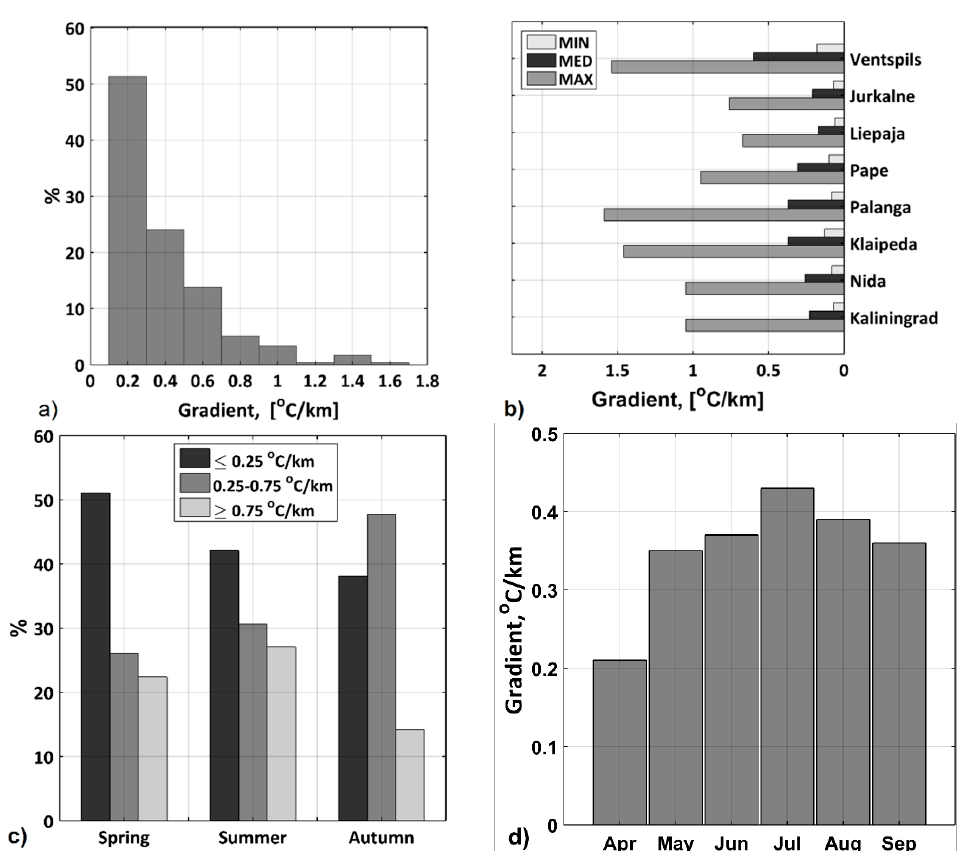
Figure 8. Upwelling-induced SST gradients for the period 2000–2015: ( a ) histogram of horizontal SST gradients; ( b ) spatial distribution of SST gradients along the SEB coast; ( c ) seasonal changes of SST gradients; ( d ) mean monthly SST gradients.